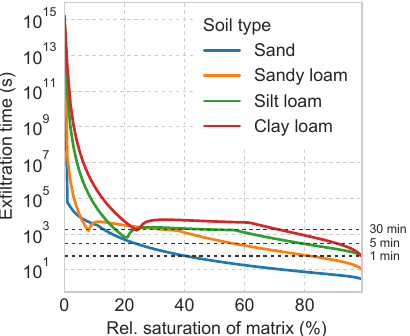
Figure C1. Exfiltration time of a particle from the macropore wall into the adjoined soil matrix for different soils and soil moisture states.